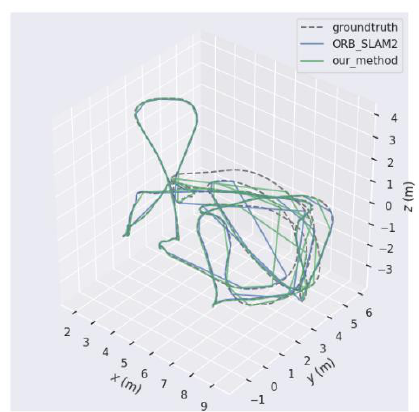
Figure 10. Trajectory graph of MH03 predicted by ORB_SLAM2 and our system.